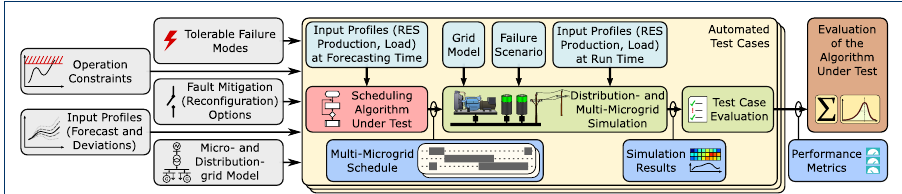
Figure 1 Advanced Resiliency-Oriented Control Algorithm